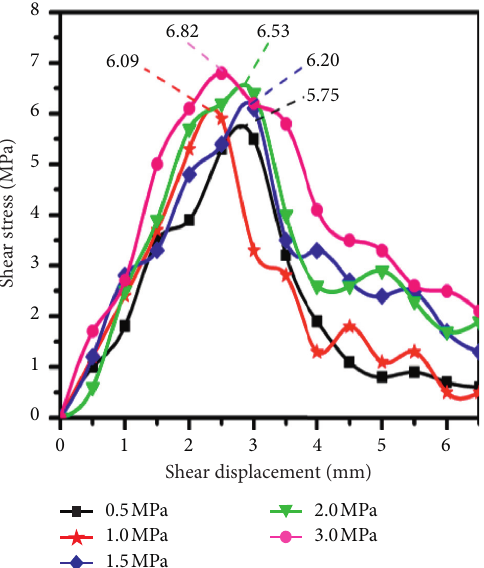
Figure 7: Complete shear-displacement-shear stress curves of nonpenetrating jointed rock mass under different normal stress